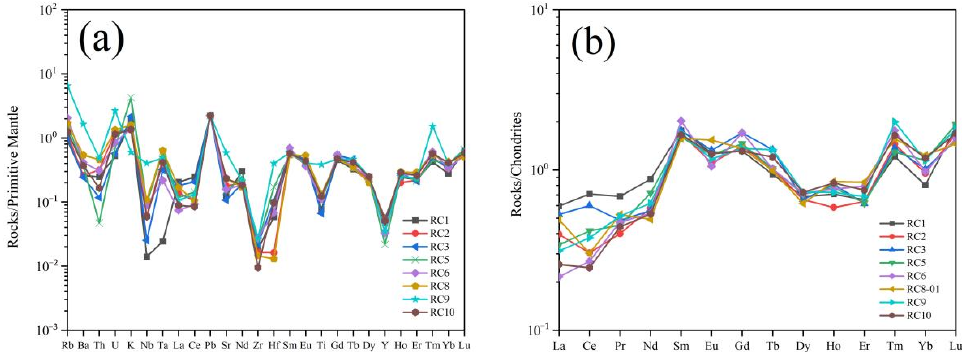
Figure 8. ( a ) Primitive mantle-normalized trace element diagrams of selected samples. ( b ) Chondrite-normalized REE patterns of selected samples. Table 3. Data on rare earth elements in the selected samples (ppm).